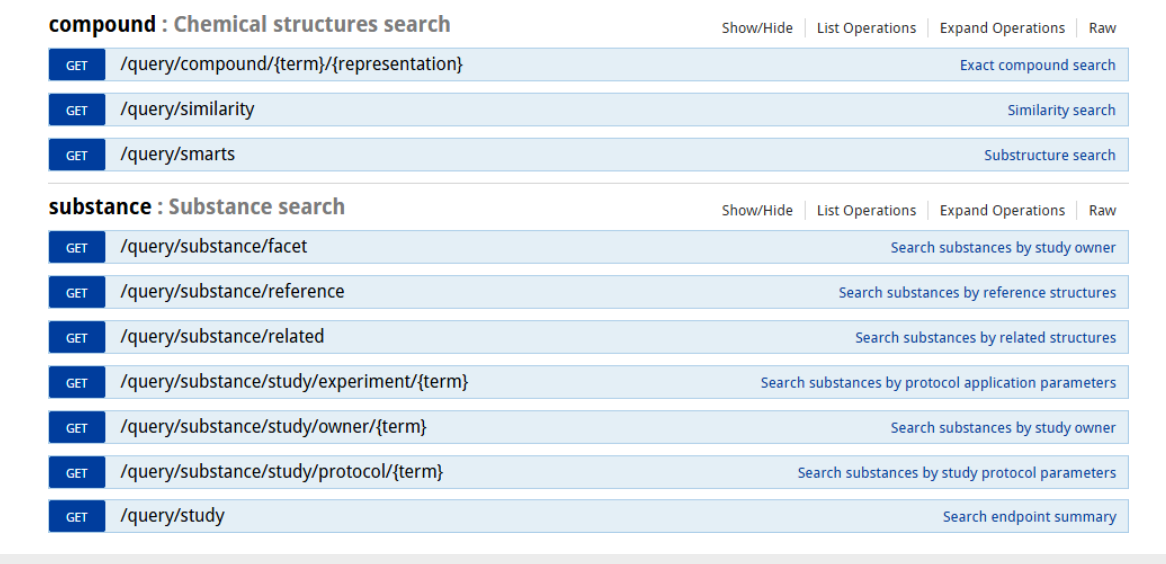
Figure 6: Compound, substance and study search API documentation.